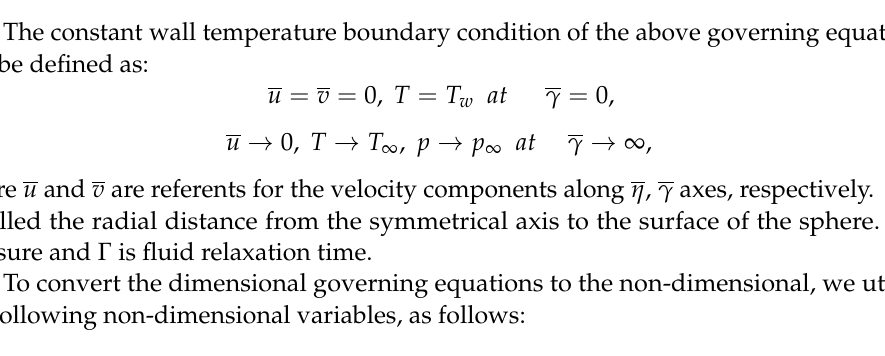
Figure 1. MHD Williamson hybrid nanofluid physical model.